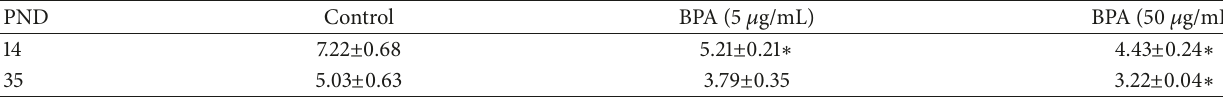
Table 3: Serum testosterone concentration in male pups ( 𝜇